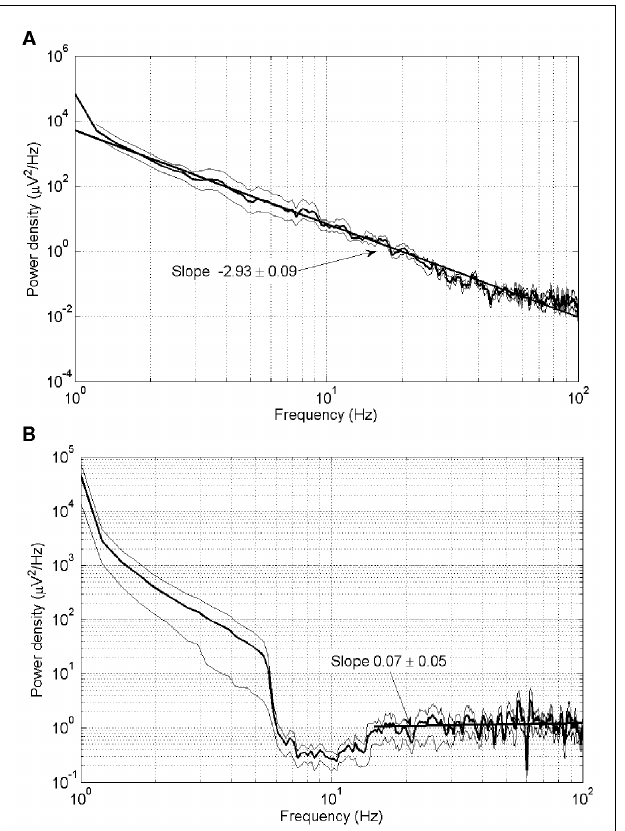
FIGURE 3 | Power density spectra for (A) waking ECoG and (B) postictally unconscious ECoG. Thick lines: mean of all four subjects.Thin lines: plus and minus one SD from the